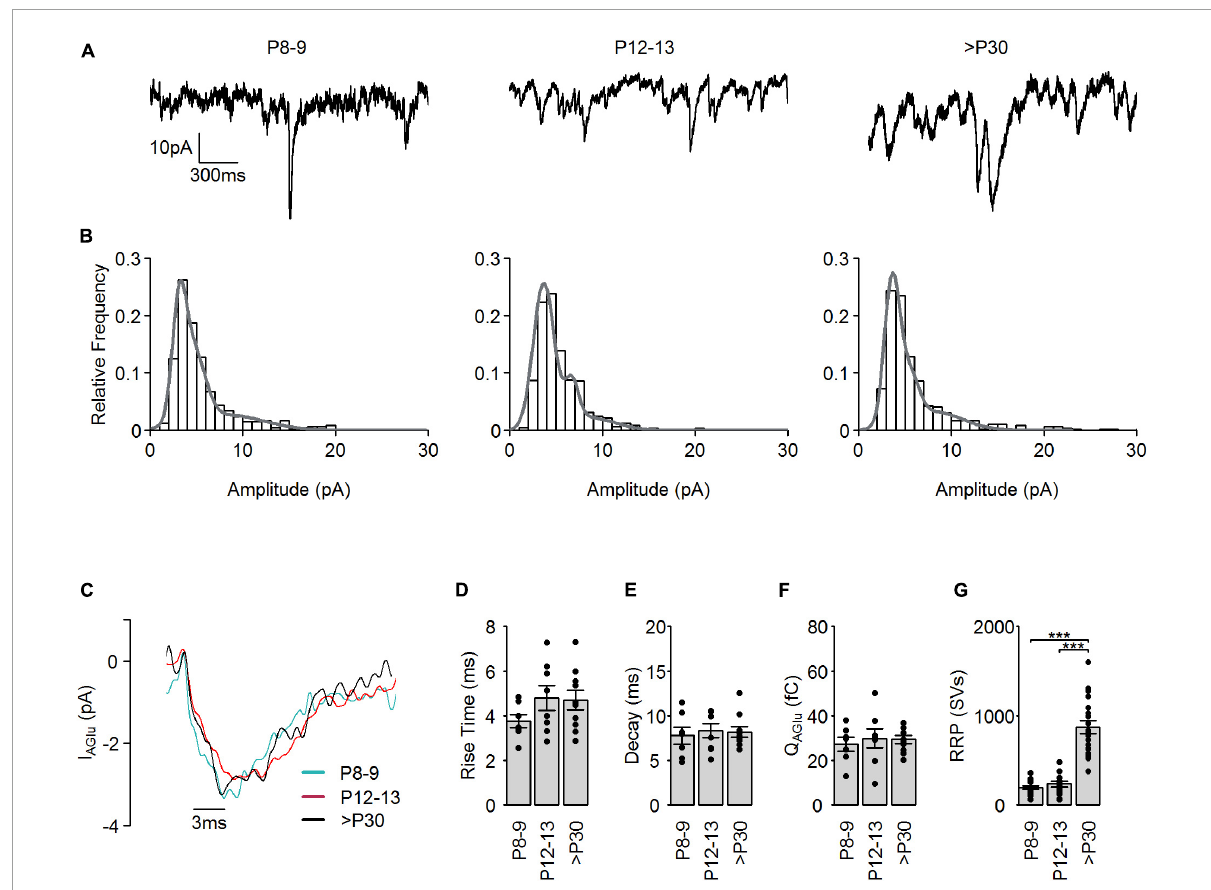
FIGURE3 Spontaneous SV release in developing cone photoreceptors. (A) Representative spontaneous I AGlu events recorded at V h = –60 mV at the different developmental stages. (B) Amplitude histograms of spontaneous I AGlu events (bin = 1 pA) at the different developmental stages. Gray line shows a fit of the distribution to a multiple Gaussian function. (C) Representative single SV I AGlu events recorded at V h = –60 mV at the different developmental stages. (D) 10–90% rise time of single I AGlu events ( p = 0.469, n = 7–10 cells, one-way ANOVA). (E) Tau of a single exponential decay of single I AGlu events ( p = 0.848, n = 7–10 cells, one-way ANOVA). (F) Charge transfer of single I AGlu events ( p = 0.853, n = 7–10 cells, one-way ANOVA). (G) RRP, calculated by dividing the charge transfer of evoked I AGlu events by the mean charge transfer of single I AGlu events for each developmental stage ( p < 0.001, n = 11–16 cells, Kruskal-Wallis test). Post hoc Mann–Whitney U -test (P8–9 vs. P12–13: p = 0.42, P8–9 vs. > P30: P < 0.001, P12–13 vs. > P30: p <